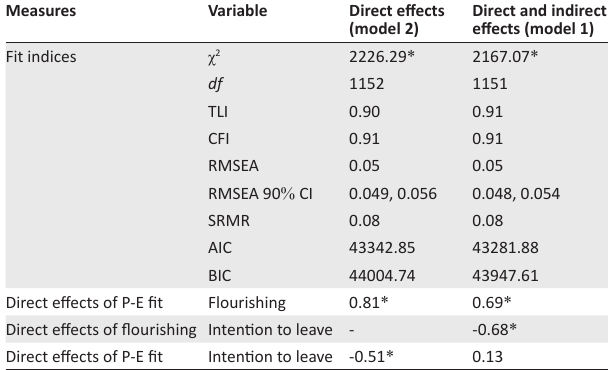
TABLE 5: Fit indices and standardised path coefficients of the structural